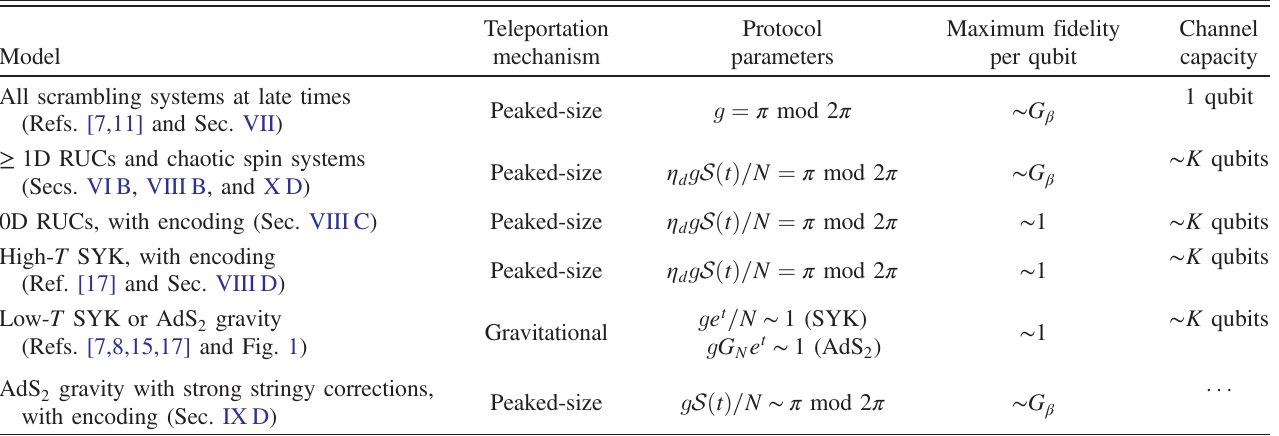
TABLE I. Summary of our expectations for teleportation in a variety of physical models. For each model, we specify the associated teleportation mechanism, the optimal value of the coupling strength g , the optimal teleportation fidelity, and the channel capacity. Here, G β is the imaginary time two-point function (Sec. VI B), S ð t Þ is the size of a time-evolved operator, K is the number of measured qubits 1 = ð 1 − 1 =d 2 Þ is an order one constant determined by the local qudit dimension d (Sec. VA), and G [Fig. 1(a)], η d ¼ constant. We refer to the summary of results and the cited sections for further